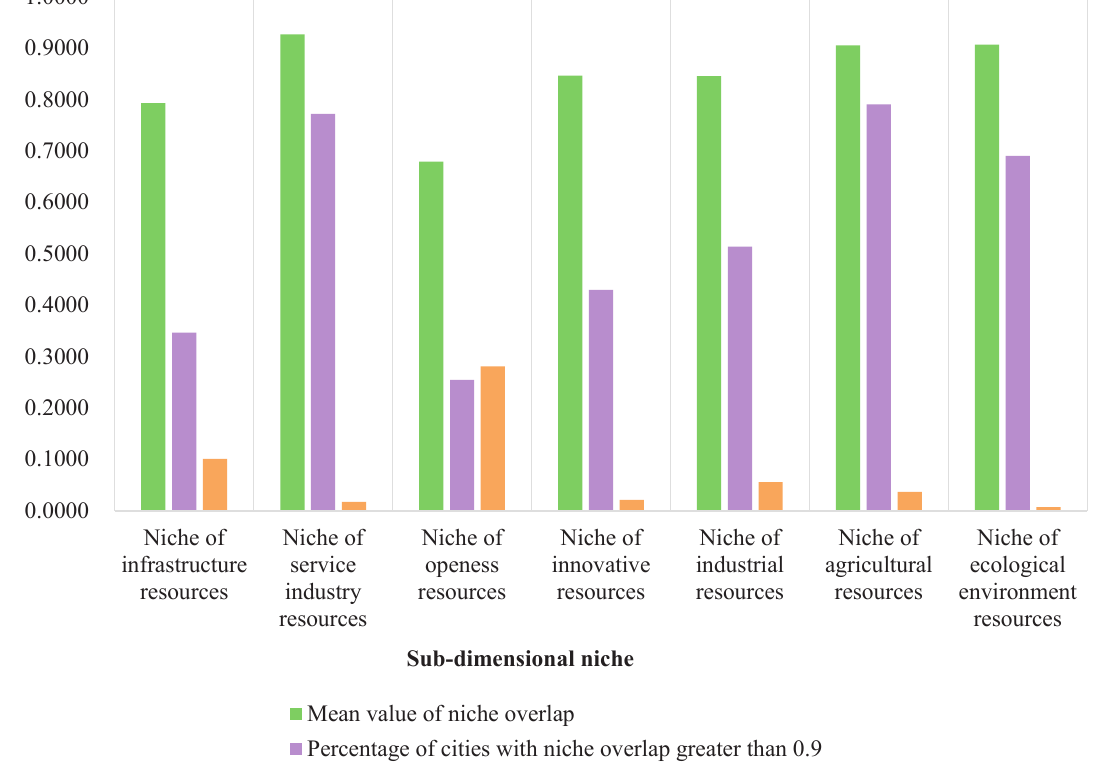
Figure 4. Statistical map of the niche overlaps of YRB cities in